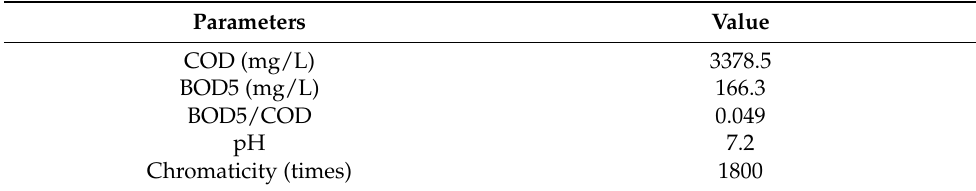
Table 1. Characteristics of the leachate.